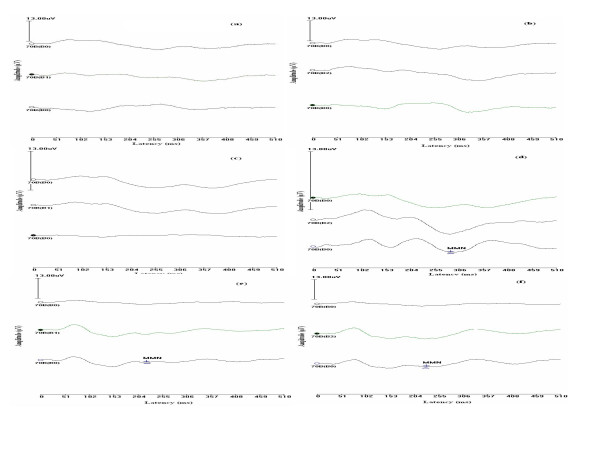
(a to f). The figure shows grand mean MMNs of clinical group. Figure 2a to 2f represents the waves elicited for /tΣa/-/dZa/, /tΣa/-/sa/, /da/-/δ8a/, /da/-/das/, tonal frequency and tonal duration contrasts respectively. Each sub-figure has a standard, a deviant and a difference wave respectively. The waves are scaled to 13 μV and the MMN is marked on the difference wave.